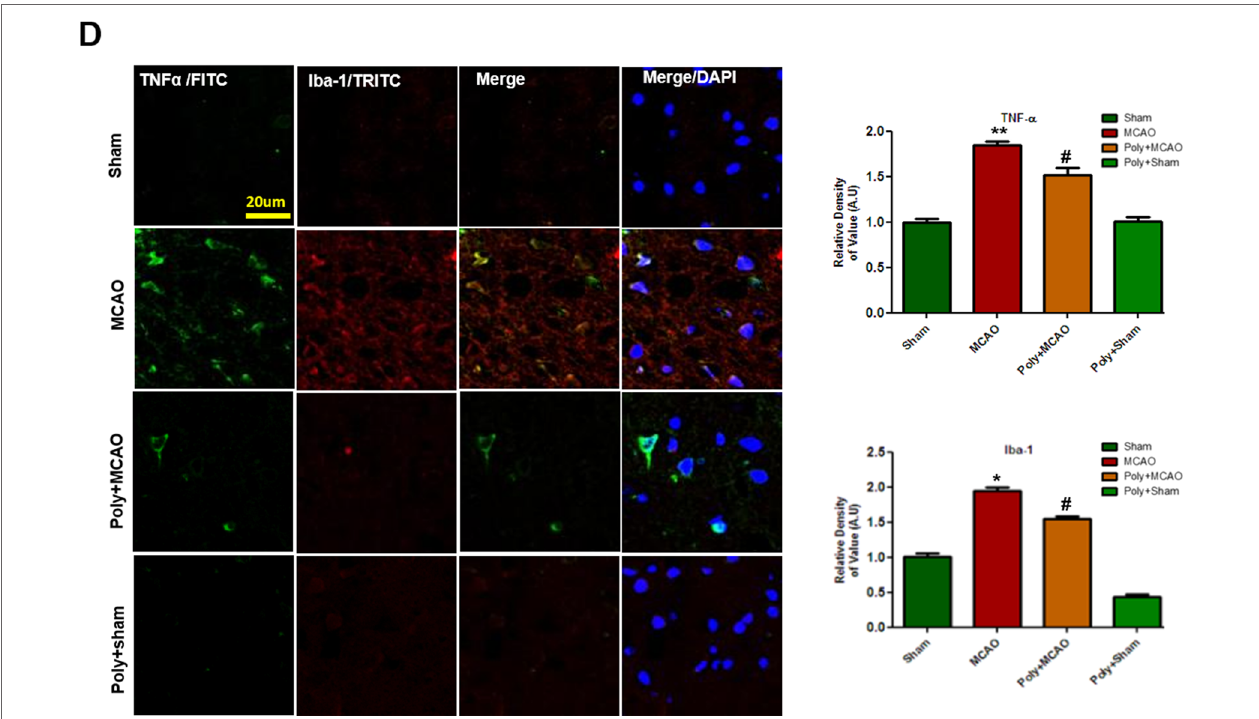
FIGURE 3 | Polydatin attenuated reactive gliosis and inflammatory mediators in MCAO injury. (A) Immunoreactivity of astrocytes (GFAP-positive cells) in the sham, MCAO, and Poly+MCAO groups are shown. Scale bar = 40 μm. The GFAP-positive cells were visualized by TRITC. Data presented are relative to Sham and number of experiment performed = 3, and (n = 5–7/group). (B) Effect of polydatin on inflammatory cytokines. Western blot analysis of TLR4, TNF α , and IL-1 β (n = 5–8/group). The Western blots were quantified using ImageJ and analyzed by GraphPad Prism 5 software. β -Actin was used as a control. (C) Immunohistochemistry results for IL-1 β are shown; scale bar = 50 µm. (D) Double immunofluorescence reactivity of TNF and Iba-1. Scale bar = 20 μm. The cortical sections show correspondingly elevated expression of TNF and Iba-1 after 24 h of permanent ischemia. TNF is visualized with FITC and IBa-1 by TRITC (n = 5-7/group). *** p < 0.001; ** , ## p < 0.01; # p <